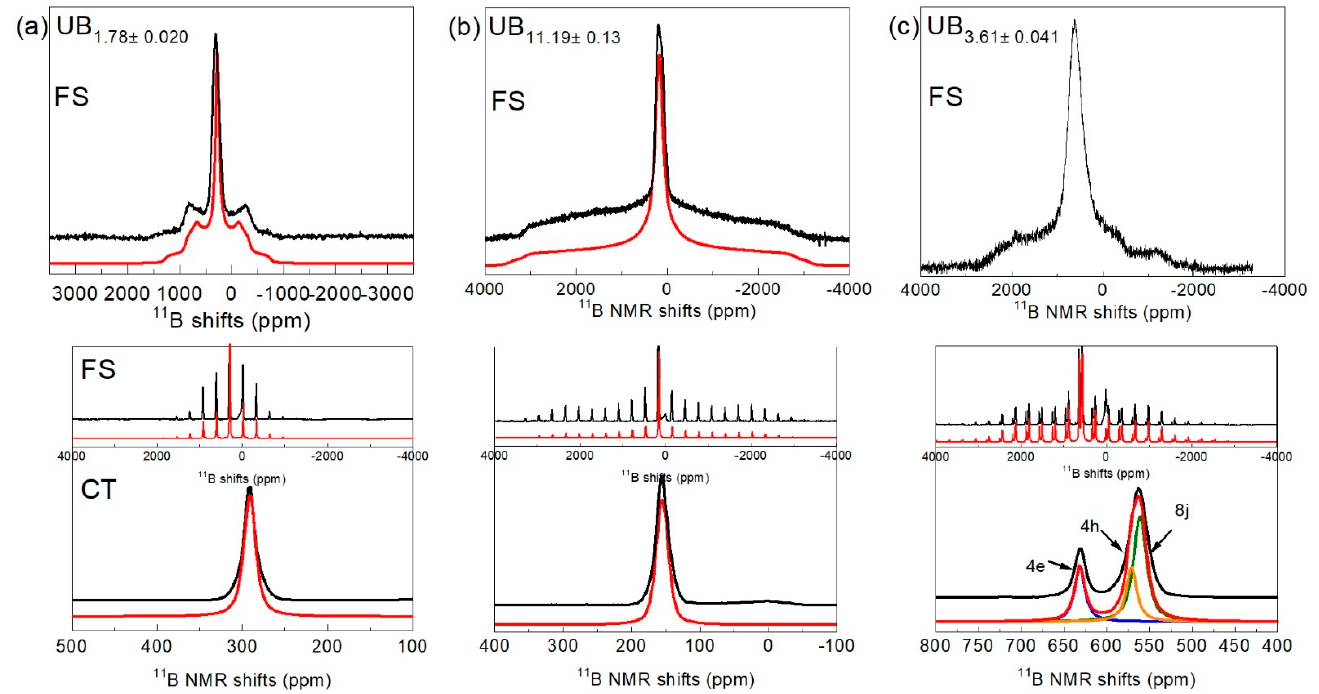
Figure 4. 11 B static (upper) and MAS-NMR spectra (lower) for ( a ) UB 1.78 , ( b ) UB 11.19 , and ( c ) UB 3.61 showing the central transition (CT) and the Full spectra (FS). The fits are the red lines.